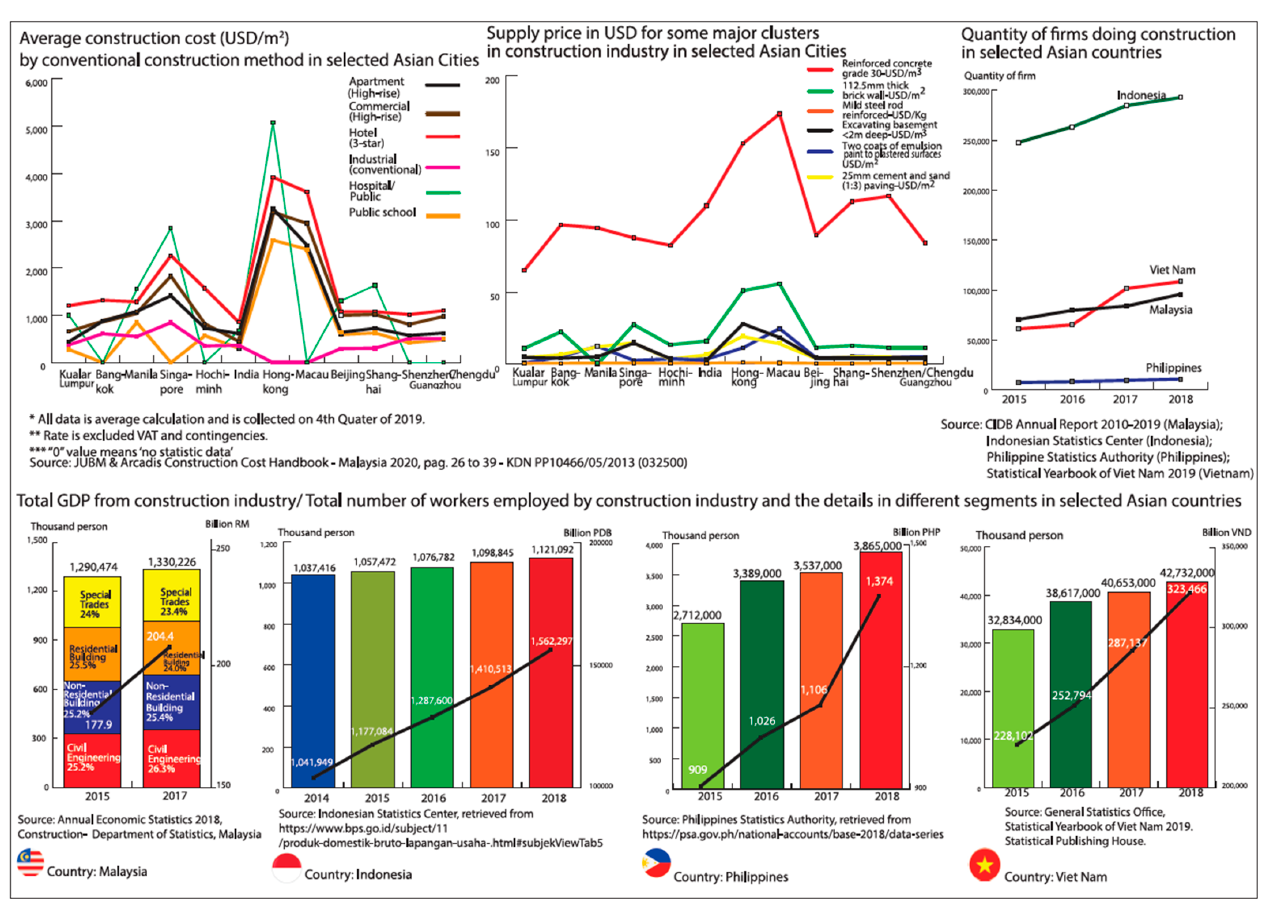
Figure 1. Statistical details relevant to construction in Vietnam, Indonesia, the Philippines, and Malaysia. Sources: [23–28].